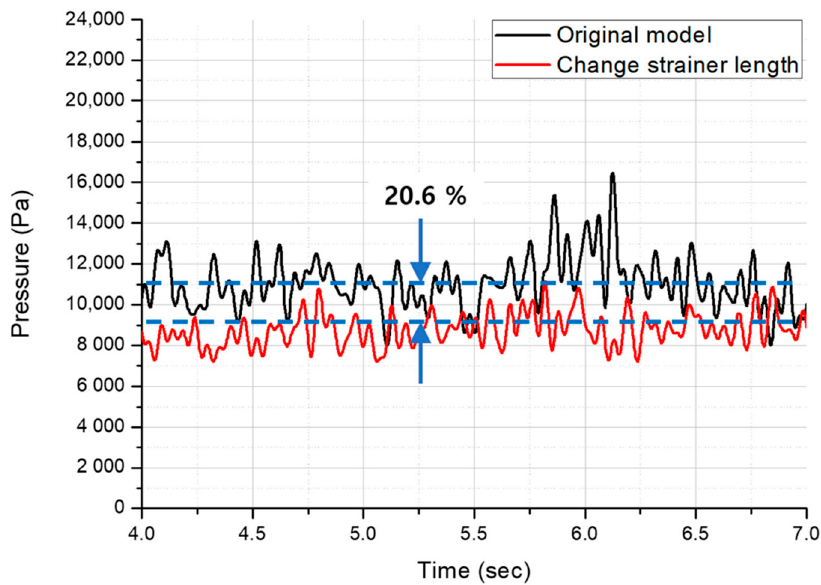
Figure 9. Average value of the pump internal pressure.